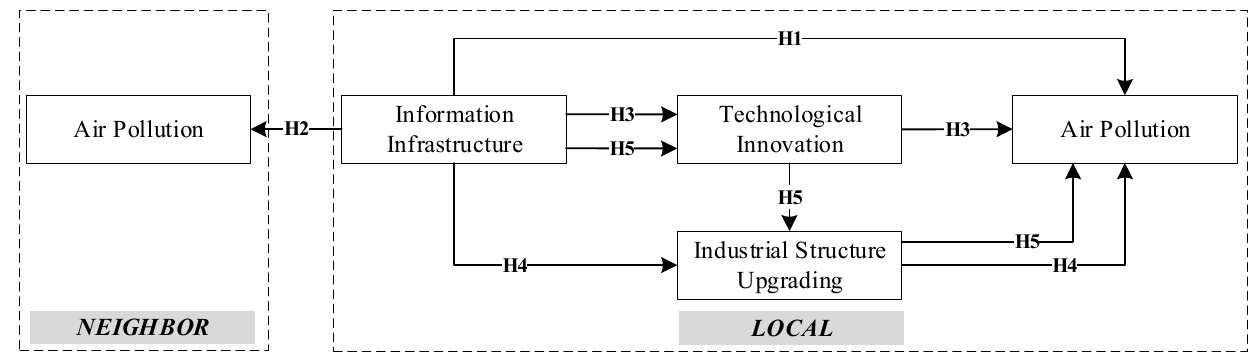
Figure 1. Conceptual framework of the impact of information infrastructure on air pollution.